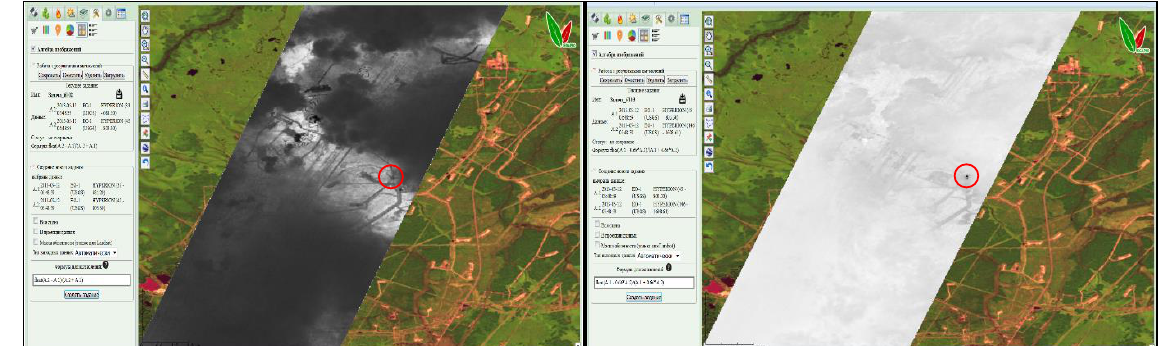
Figure 14. NDVI (a) and AFVI1600 (b) images over gas flare site (red circle). Hyperion observations (20.05.13, West Siberia)